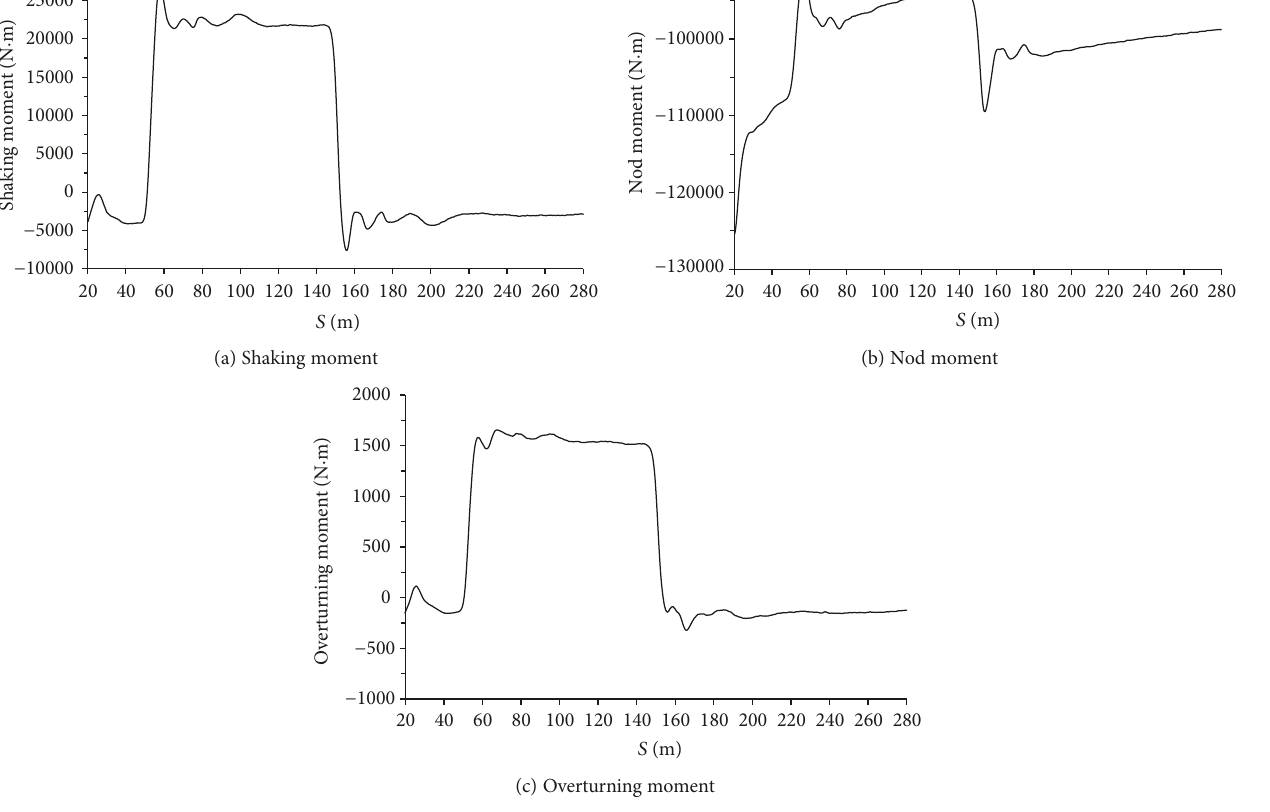
Figure 18: Changing of aerodynamic moments of the head